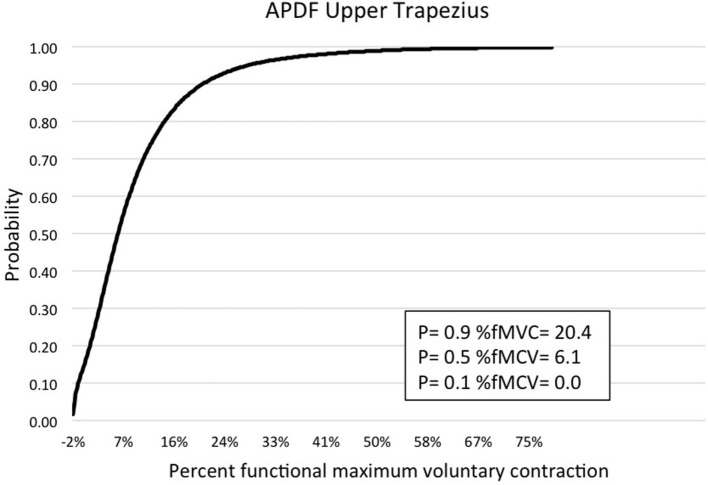
Graphic representation of typical APDF of the upper trapezius.